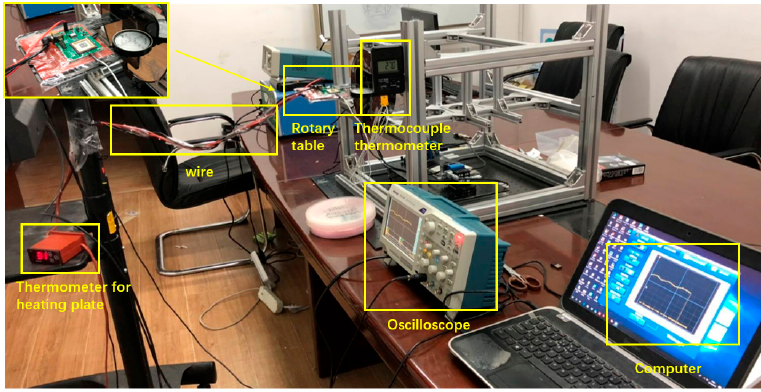
Figure 19. Experimental device.